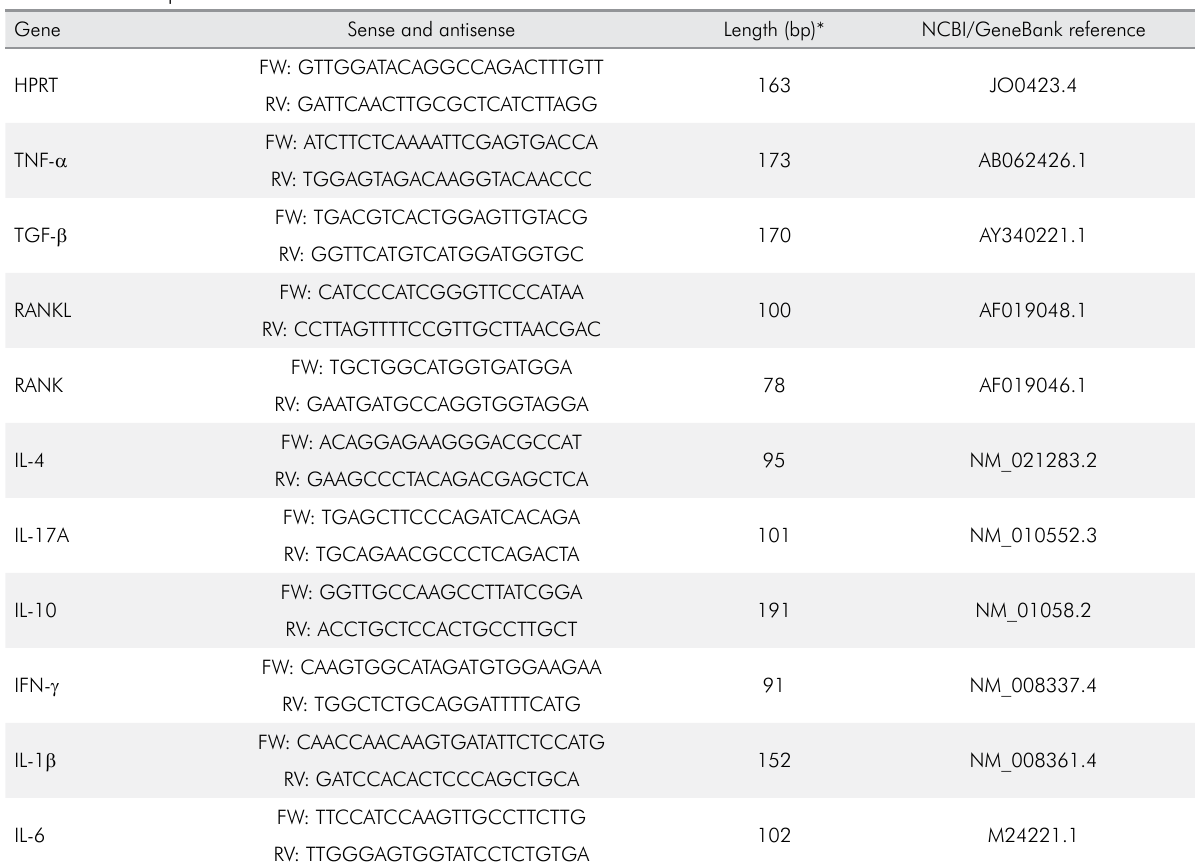
Table. Primer sequences used in PCR